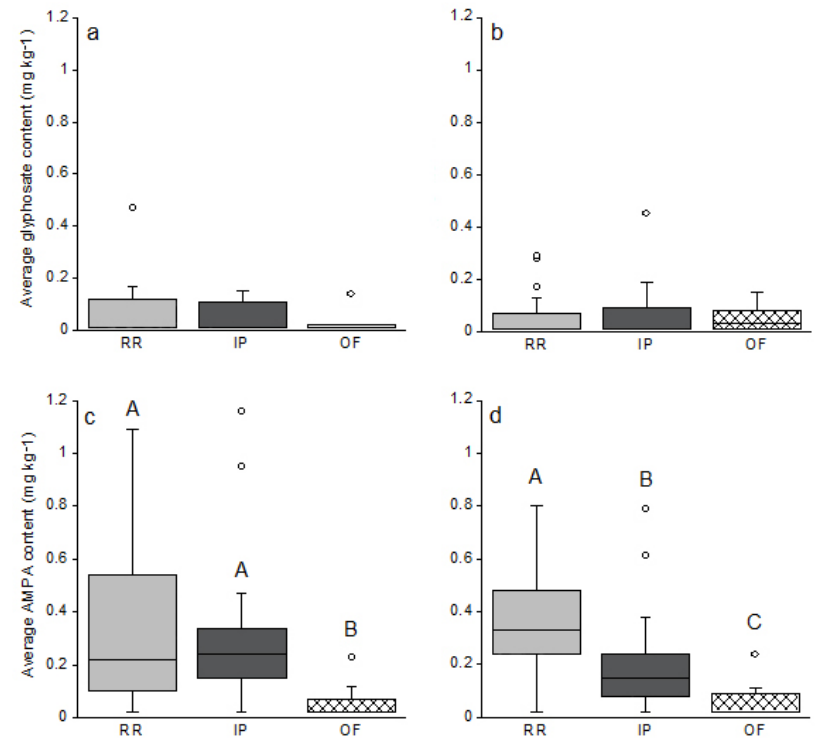
Figure 2. Glyphosate ( a , b ) and AMPA ( c , d ) content according to the agricultural system used in May 2014 before sowing ( a , c ) and in October 2014 ( b , d ) at harvest time for the three cropping systems RR (Roundup Ready); IP (Identity Preserved) and OF (Organic Farming). For RR, n = 21; IP n = 16 and OF n = 8. Boxplots represent the median, and the 25 and 75 % quantiles. Circles ◦ represent potential outliers. Significant differences were tested using the non-parametric Kruskal–Wallis test, with a significant threshold set at 0.05 and annotated on the graph with letters A, B and C corresponding to the different significant groups. When there is no letter, it means that no significant differences were observed between the three